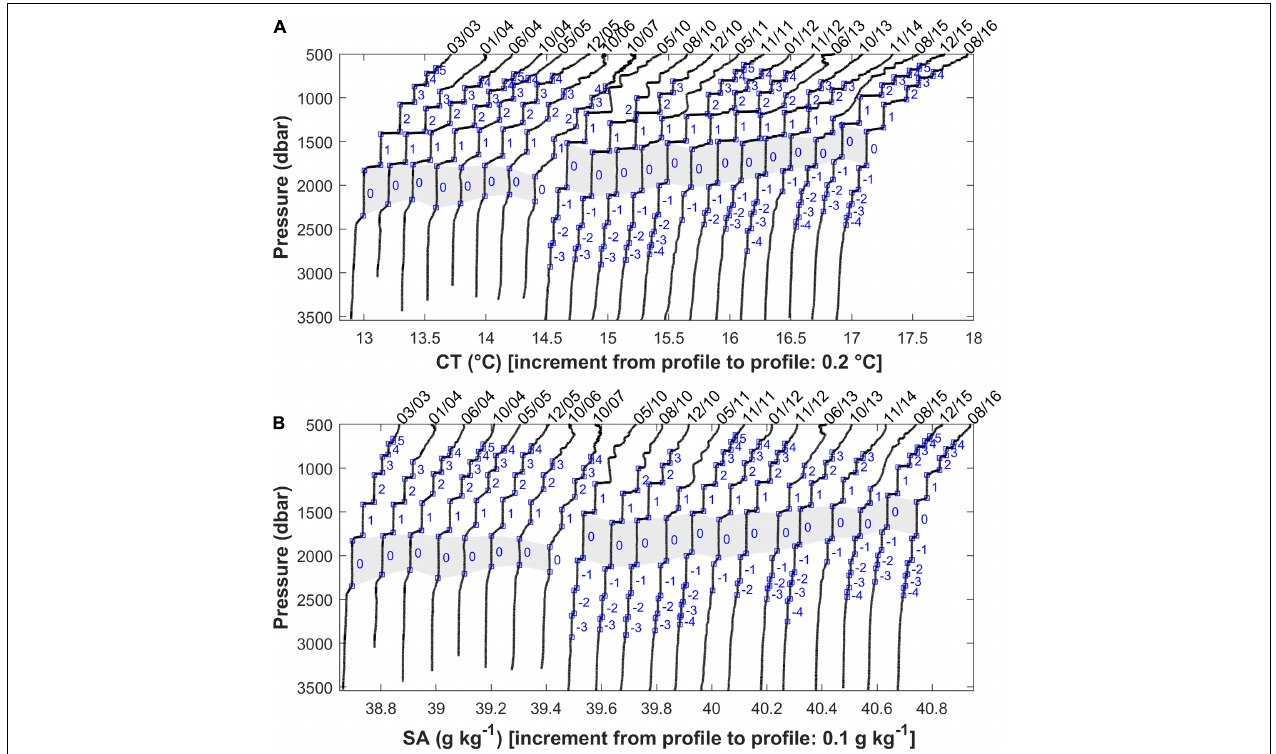
FIGURE 3 | Original (i.e., not smoothed) temperature (A) and salinity (B) profiles from each cruise with the relevant selected corner points (blue squares) overlaid on each one; the temperature profiles are offset by 0.2 ◦ C and the salinity profiles by 0.1 g kg − 1 from cruise to cruise for better viewing. The gray band highlights the thickest layers found, numbered “0.” The layers above and below it are labeled sequentially with positive and negative numbers, respectively, in their natural order of succession going up or going down.